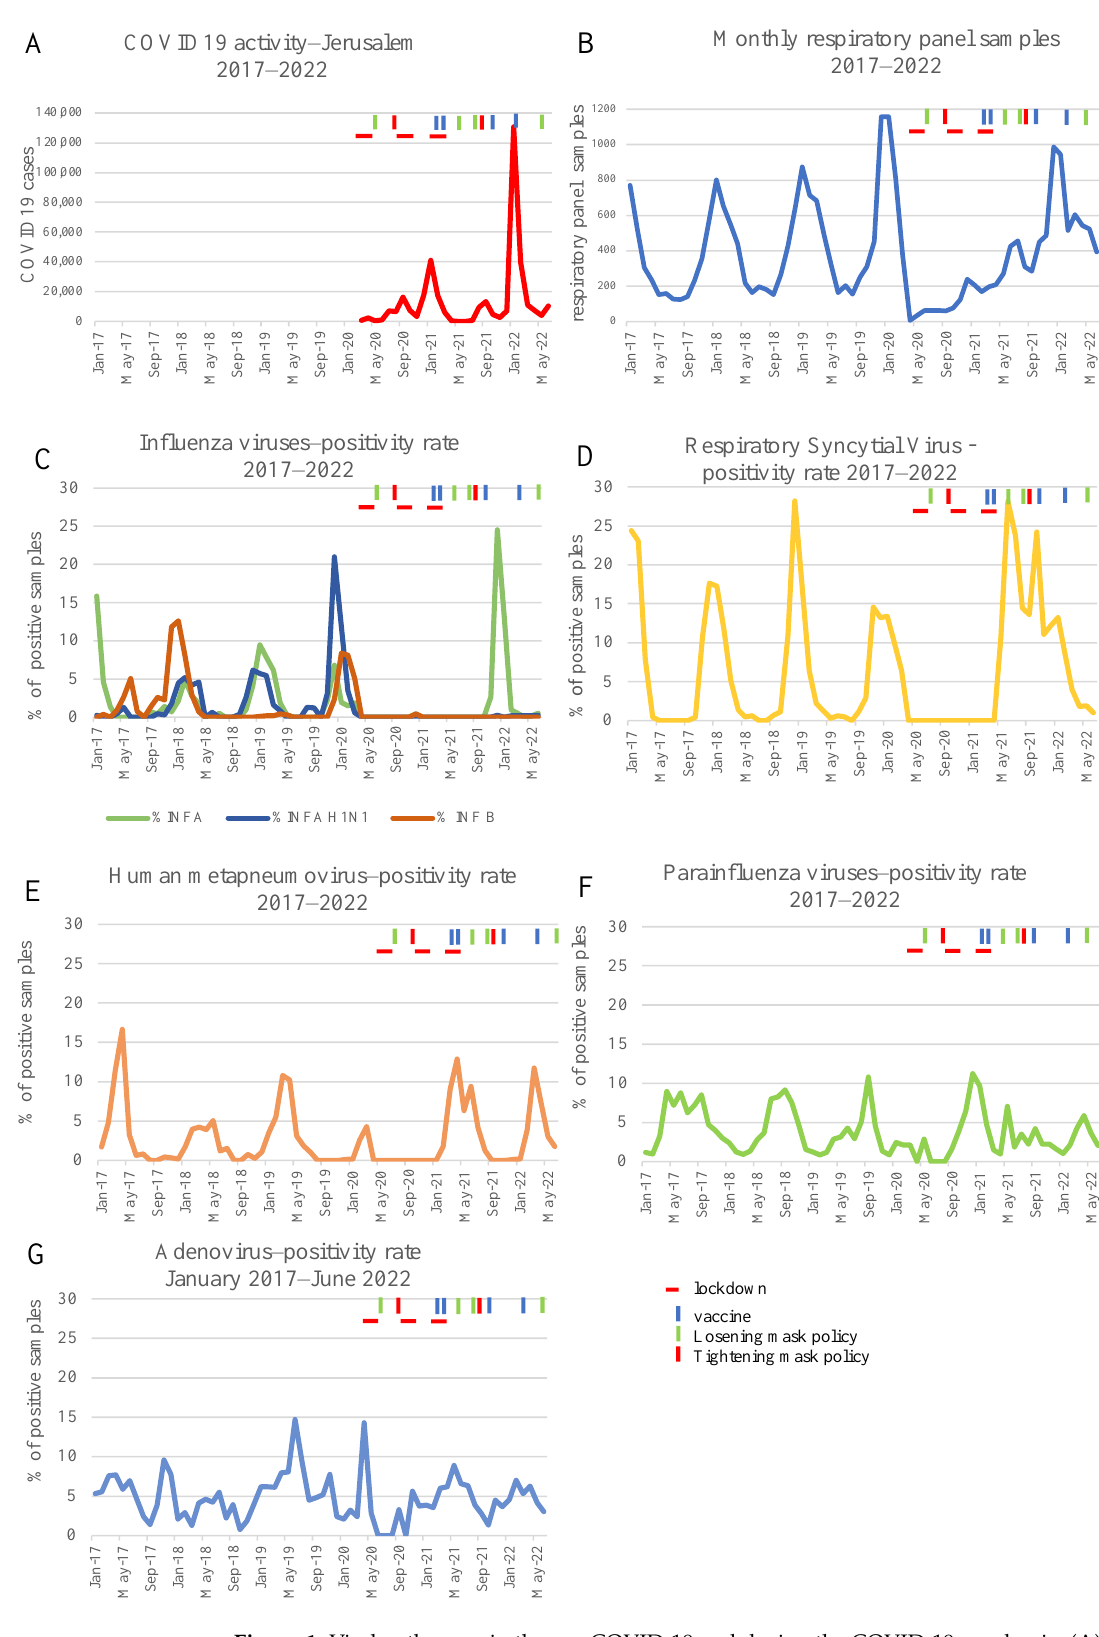
Figure 1. Viral pathogens in the pre-COVID-19 and during the COVID-19 pandemic. ( A ). COVID-19 activity-Monthly COVID-19 cases in Jerusalem district. ( B) . Monthly viral samples submitted to